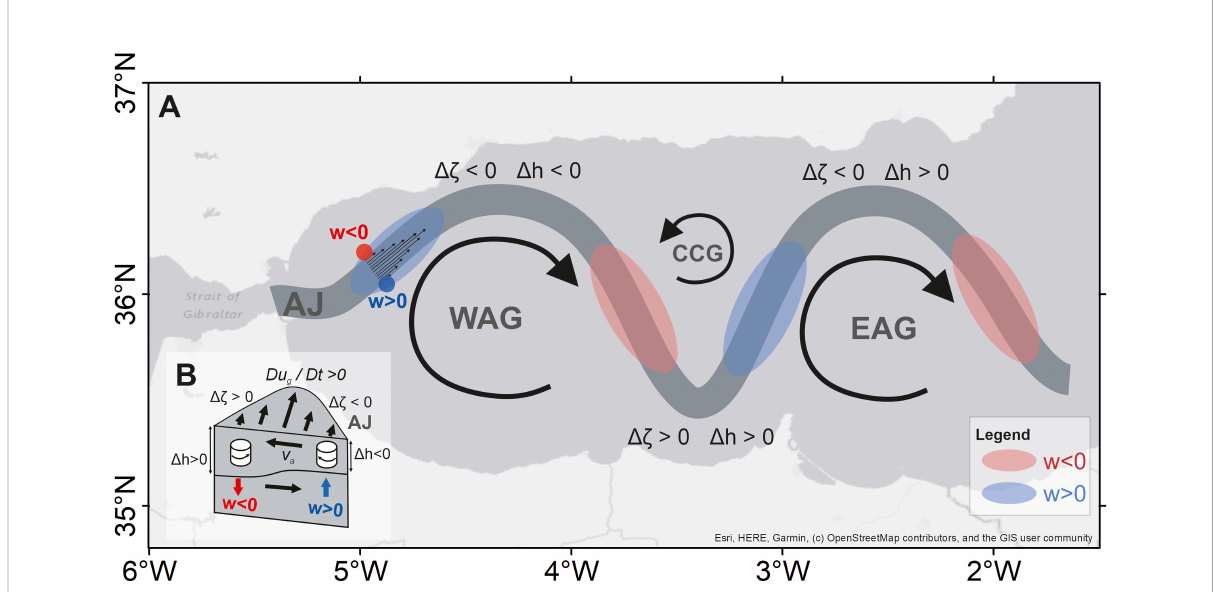
FIGURE 7 (A) Sketch of the meandering path of the AJ with vertical velocities (w) over imposed. Large patches indicate vertical velocities associated with changes of the AJ ’ s curvature vorticity over meander crests and troughs. Small-scale patches represent (stronger) vertical velocities at both sides of the AJ in response to frontogenesis. (B) Sketch of the cross-front secondary circulation due to frontogenesis (see text for details; adapted from Williams and Follows,